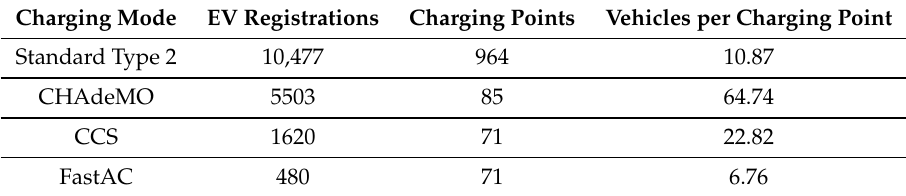
Table 1. EV registrations per charging point in